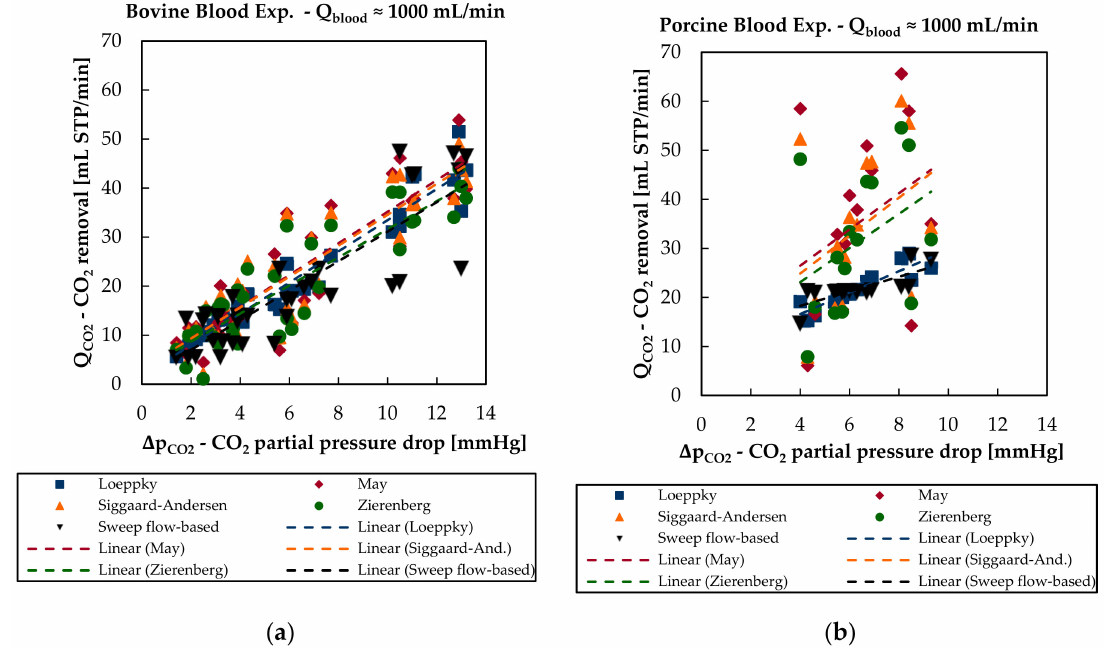
Figure 10. Sweep flow-based CO 2 removal and blood-based CO 2 removal rate of the four different CO 2 solubility models in dependency of the CO 2 partial pressure drop over the membrane module: ( a ) in vitro bovine blood trials and ( b ) in vivo porcine blood